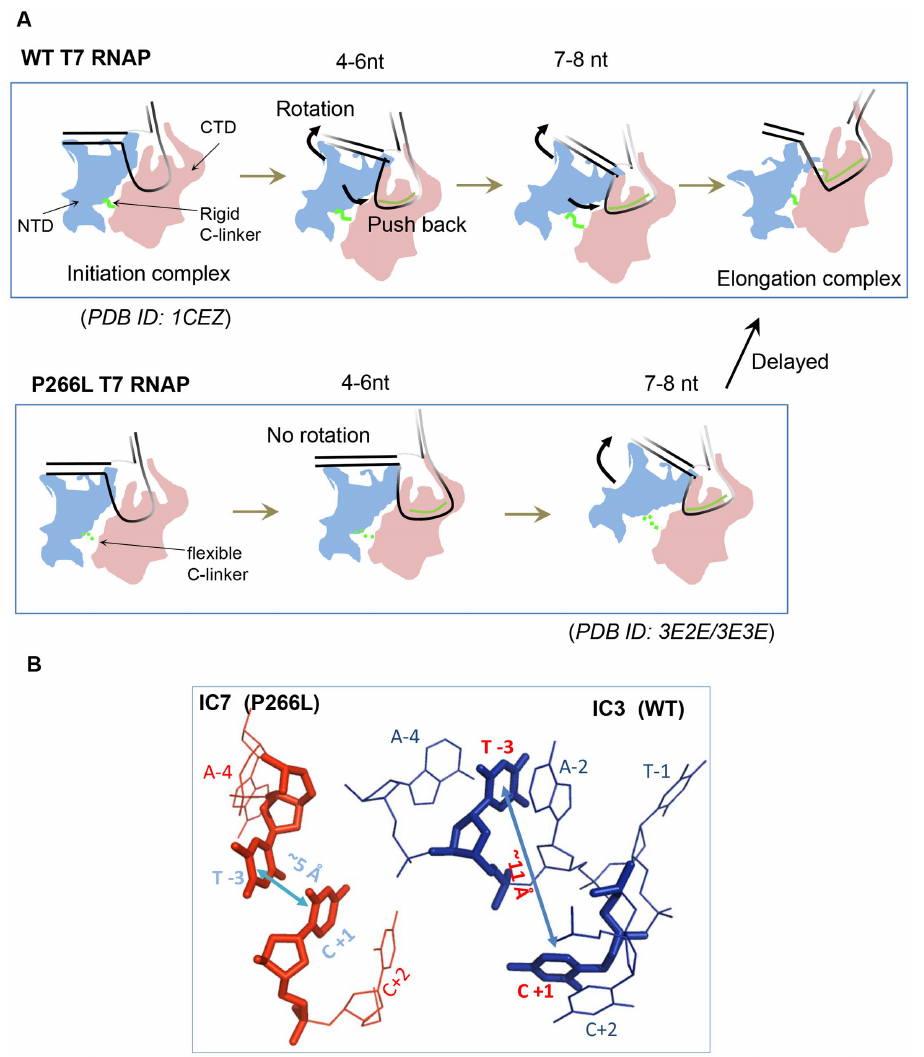
Figure 7. Distinct transcription initiation pathways of WT and P266L T7 RNAP. (A) The transcription initiation pathways of WT T7 RNAP (top) and P266L T7 RNAP (bottom) are shown in cartoon format to illustrate the distinct intermediate conformations. The N-terminal domain is shown in blue, C terminal domain in red, DNA in black and RNA in green. Movement of the N terminal domain is marked by the arrow. Both WT and P266L T7 RNAP bind, bend, and open the promoter DNA from 2 4 to + 2 to the same extent. The rigid C-linker of WT favors progressive rotation of the upstream end of the promoter to accommodate the growing hybrid from + 4 to + 6 positions, which pushes against the N-terminal domain driving the rotation of the promoter. The pushback from the N-terminal domain destabilizes the RNA:DNA hybrid and leads to abortive synthesis in WT. The flexible C-linker of P266L mutant (bottom panel) accommodates RNA extension up to 6 nt without significant promoter/N-terminal domain rotation. The reduced DNA scrunching together with the absence of promoter rotation in the 4–6 nt RNA range in P266L suggests that the growing hybrid is accommodated by an alternative pathway. After 6 nt RNA synthesis, promoter rotation and scrunching resumes in P266L. The weakened promoter interactions in WT after 9 nt RNA synthesis allow release of the N-terminal domain and transition into elongation. Persistent promoter interactions delay the transition in P266L. (B) Template strand scrunching in P266L RNAP with 7 bp RNA:DNA. Template strand from the IC3 (PDB: 1QLN) and IC7 (PDB: 3E2E) crystal structures showing decrease in the distance between C + 1 and T-3 in the IC7 structure (brown) compared to the IC3 structure (blue).